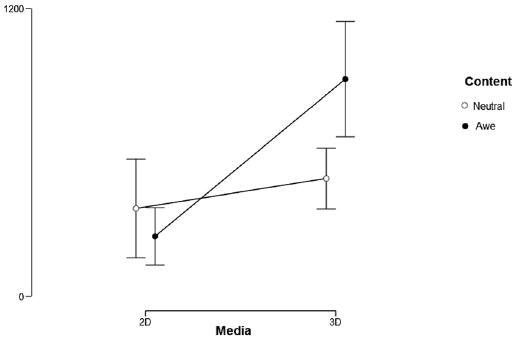
Figure 2. Interaction effect of medium and condition with HF Total power as a measure. Error bars indicate standard errors of the means.